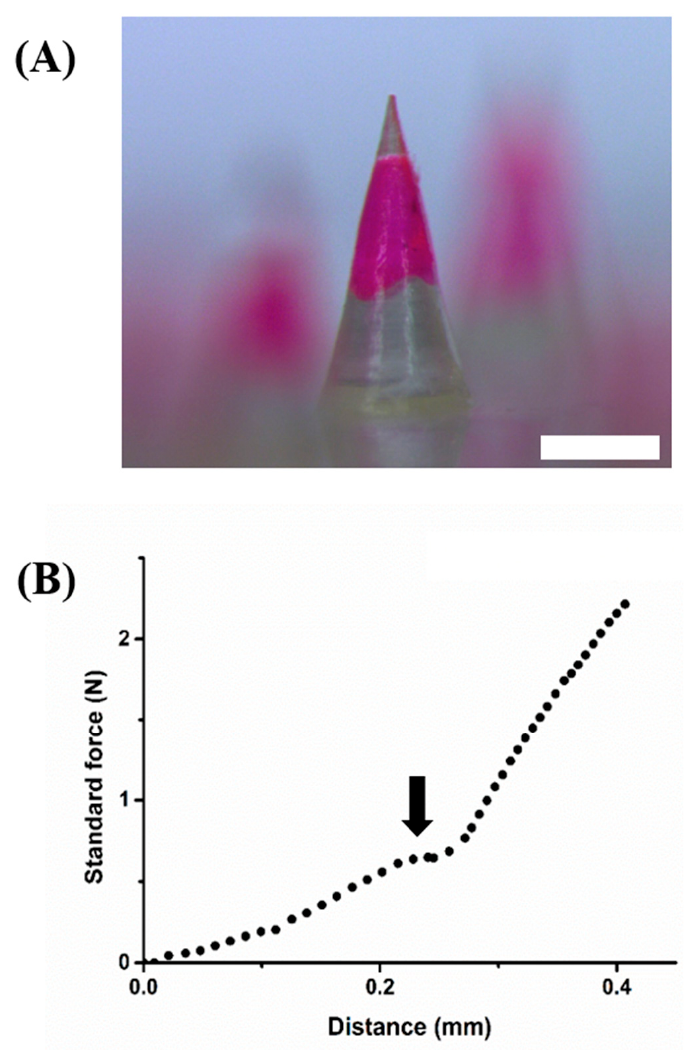
Figure 5. Morphological and mechanical properties of the HMP-DMNs. ( A ) Microscope image of a single HMP-DMN. ( B ) Fracture force of the HMP-DMN. The peak in the graph represents the frac- ture force of a single HMP-DMN. Scale bar: 500 μ m. (HMP-DMN: heat-melt PLGA dissolving mi- croneedle).